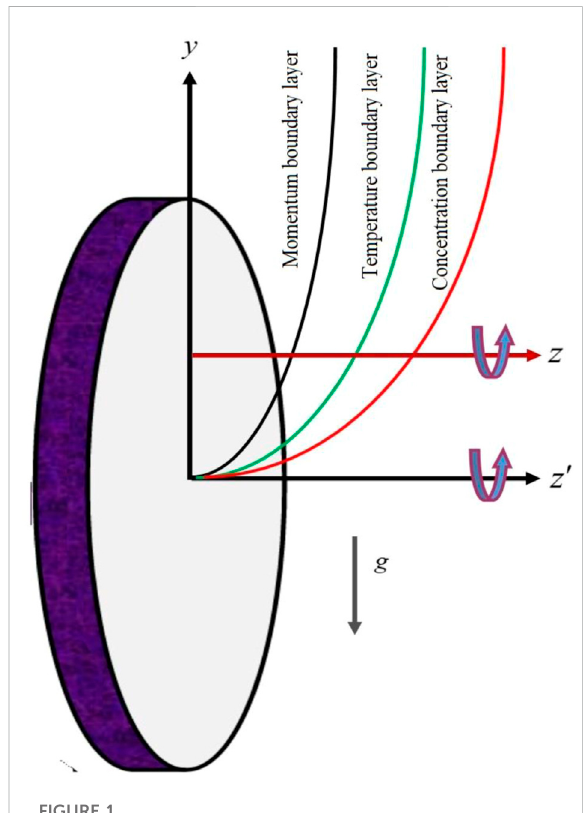
FIGURE 1 Physical sketch of fl uid fl ow across a vertical spinning